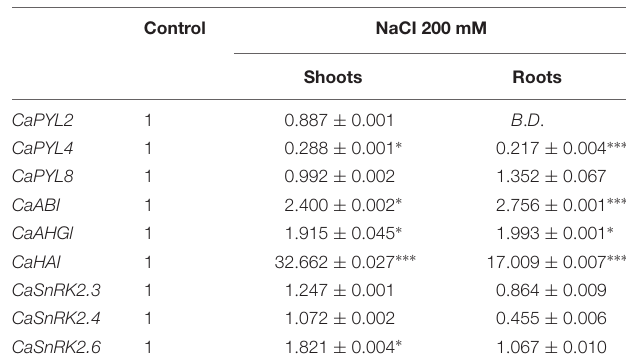
TABLE 2 | Relative quantification of gene expression measured by qRT-PCR of selected genes in roots and shoots of Quadrato D’Asti giallo seedlings grown in hydroponic system after 3 h of 200 mM NaCl treatment.